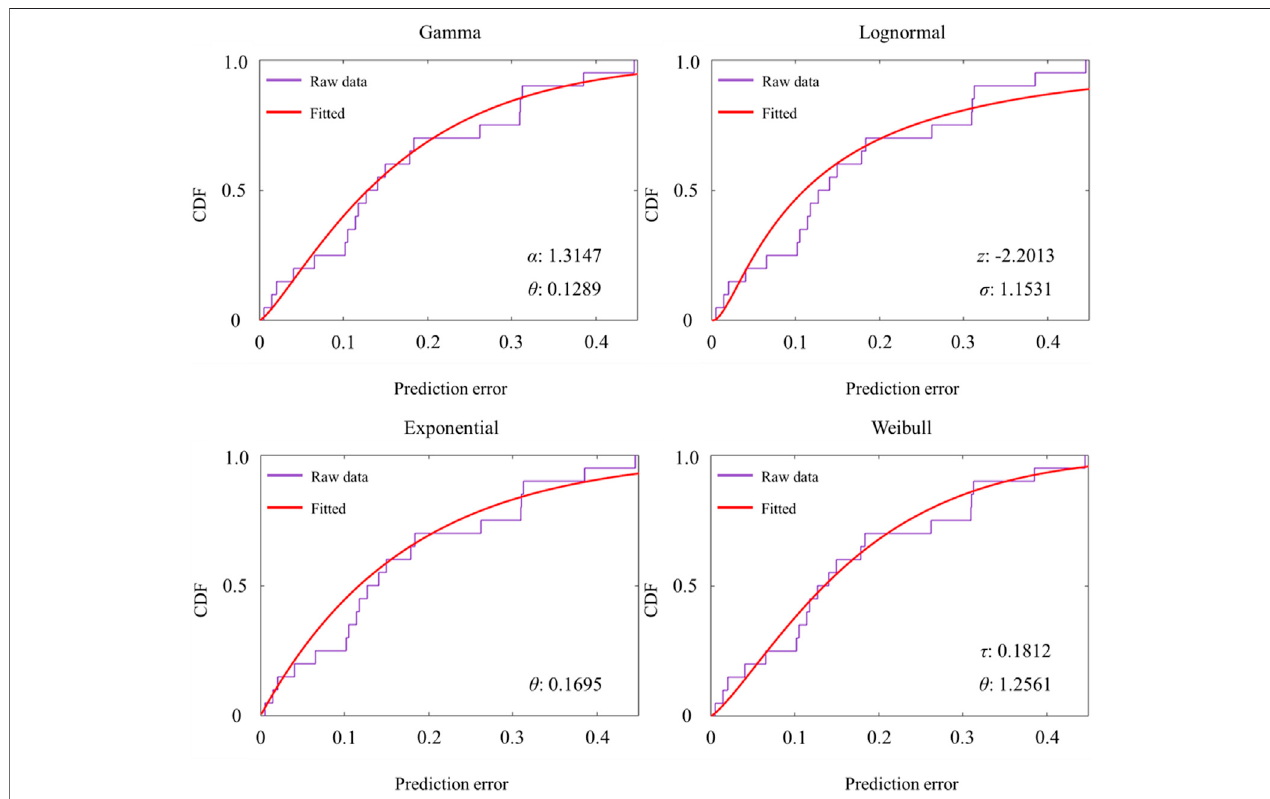
FIGURE 8 | Fitting result of forecast error probability distribution.